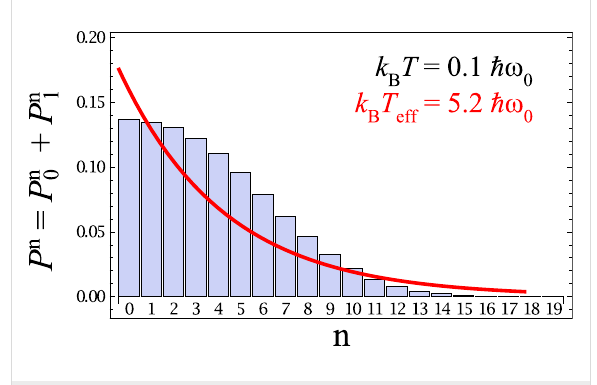
Figure 4: Phonon number distribution in nonequilibrium for eV = 5 ω 0 , m 0 = 0.5 and k B T / ω 0 = 0.1 (histogram). The solid line depicts a fit to a Boltzmann distribution. See text for